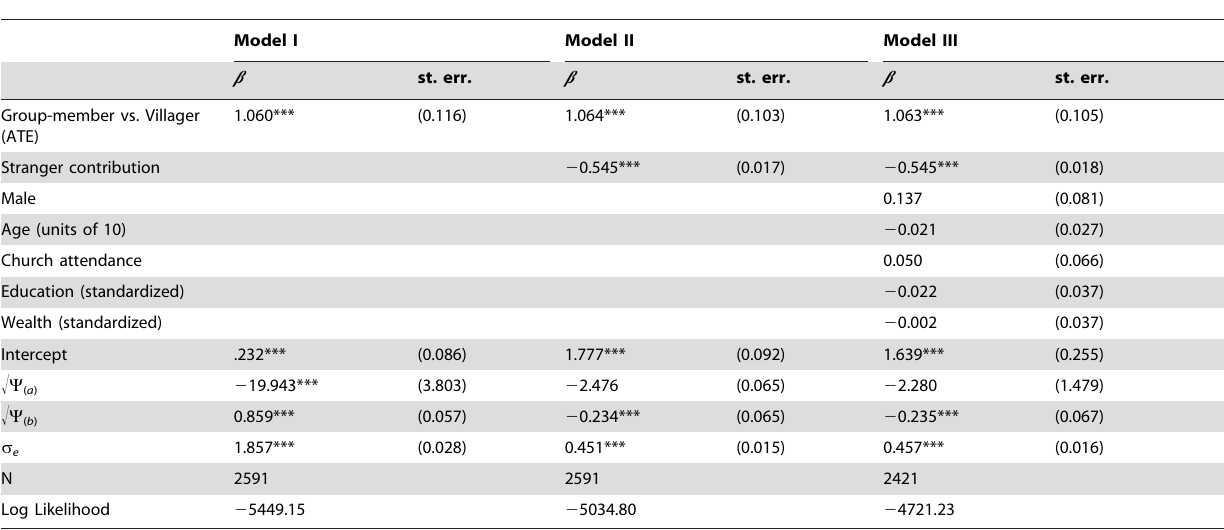
Table 1. Treatment effect of the two variants of the dictator